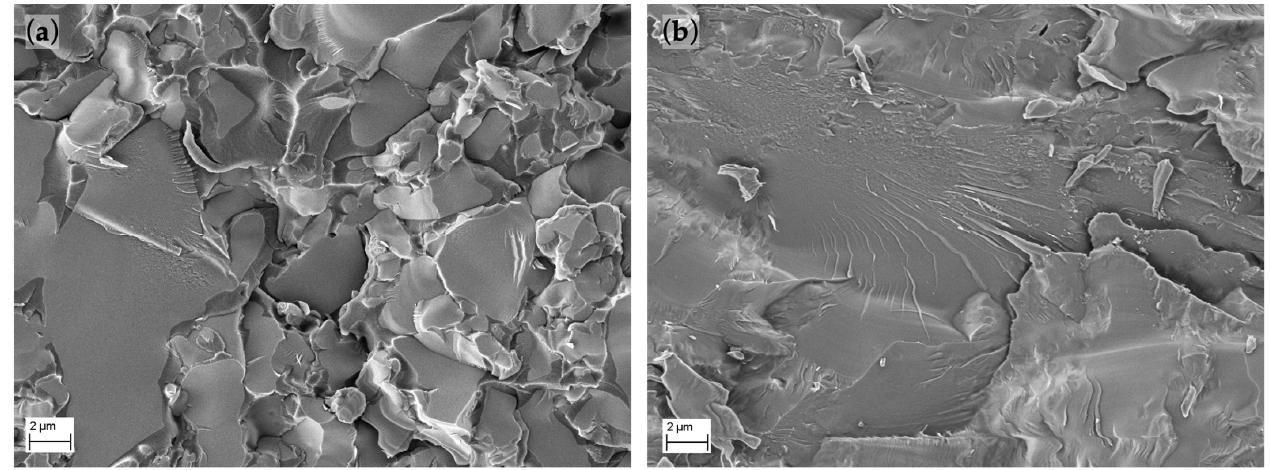
Figure 10. Representative fracture surfaces of: ( a ) VE; ( b ) EC after a TPB test of the materials AR.